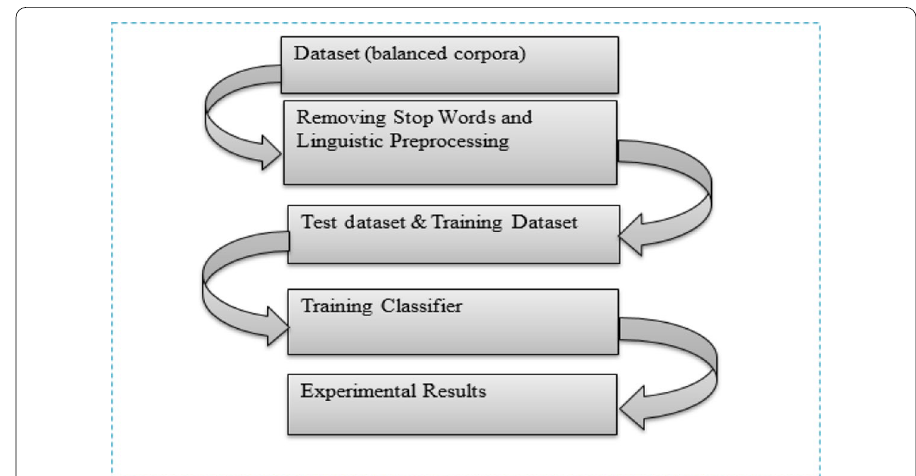
Fig. 3 Dataset training process for fake news and hate speech